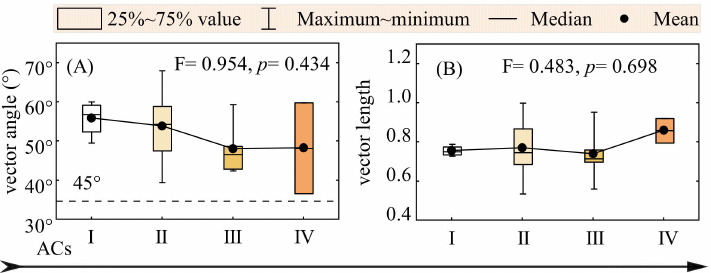
Figure 5. Eco-enzyme stoichiometry indicated nutrient limitation (vector angle, A ) and carbon limitation (vector length, B ) of microbial